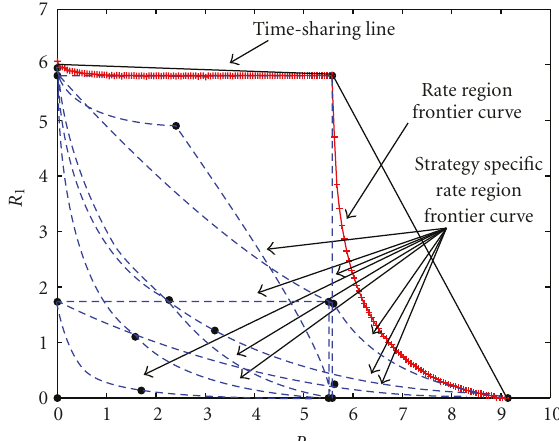
Figure 7: Achievable rate region for the OFDM interference channel—one particular channel realization, maximum transmit power of the first user is two times higher than the maximum transmit power of the second